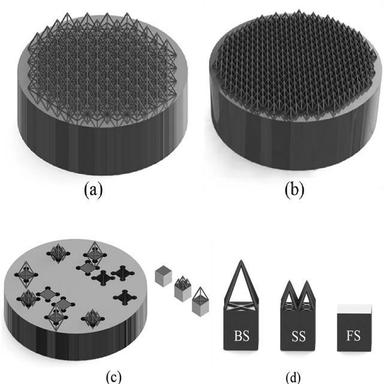
3D printed grids on platform a) Platform A with a grid of big pyramids b) Platform B with a grid of small pyramids; c) Platform C for extraction of samples for material characterization d) metal adherends for mechanical characterization.